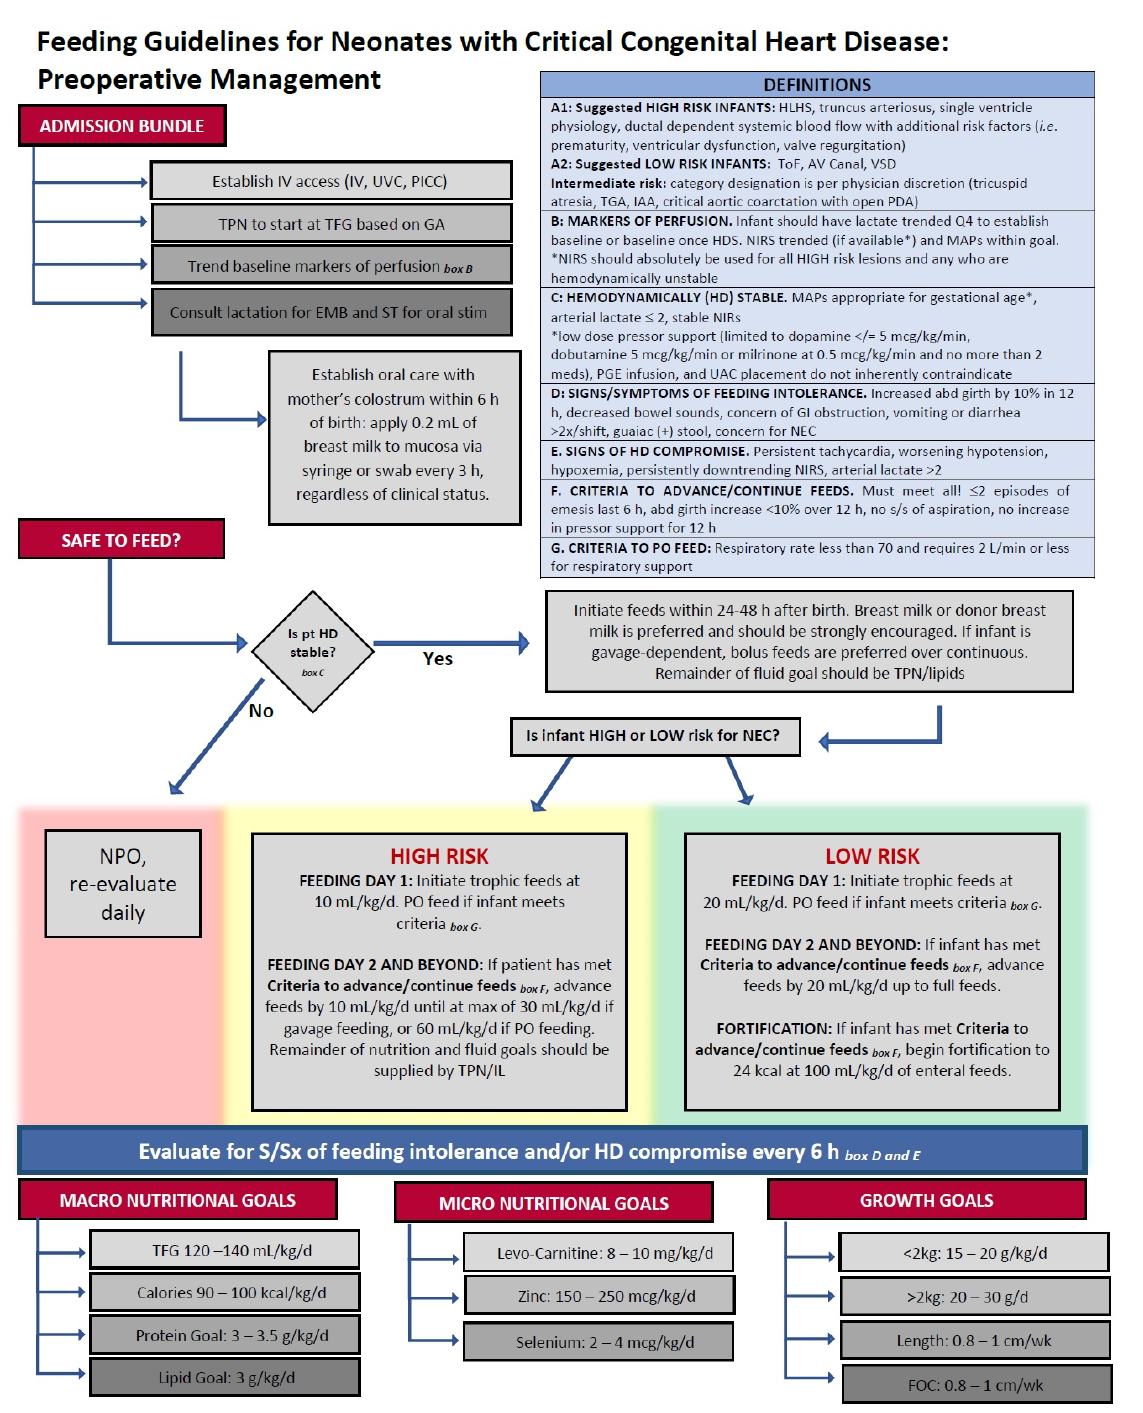
Figure 3. Representative preoperative standardized feeding protocol for neonates with congenital heart disease (CHD). IV: intravenous; UVC: umbilical venous catheter; PICC: peripherally inserted central catheter; TPN: total parenteral nutrition; IL: intralipid therapy; TFG: total fluid goal; GA: ges- tational age; EBM: expressed breast milk; ST: speech therapy; HLHS: hypoplastic left heart syndrome; ToF: tetralogy of Fallot; AV: atrioventricular; VSD: ventricular septal defect; TGA: transposition of the great arteries; IAA: interrupted aortic arch; PDA: patent ductus arteriosus; Q4: fourth quartile; HDS: hemodynamically stable; NIRS: near-infrared spectroscopy; MAPs: mean airway pressures; PGE: prostaglandin; UAC: umbilical arterial catheter; NEC: necrotizing enterocolitis; NPO: nil per os; PO: per os; S/Sx: signs and symptoms; FOC: fronto-occipital